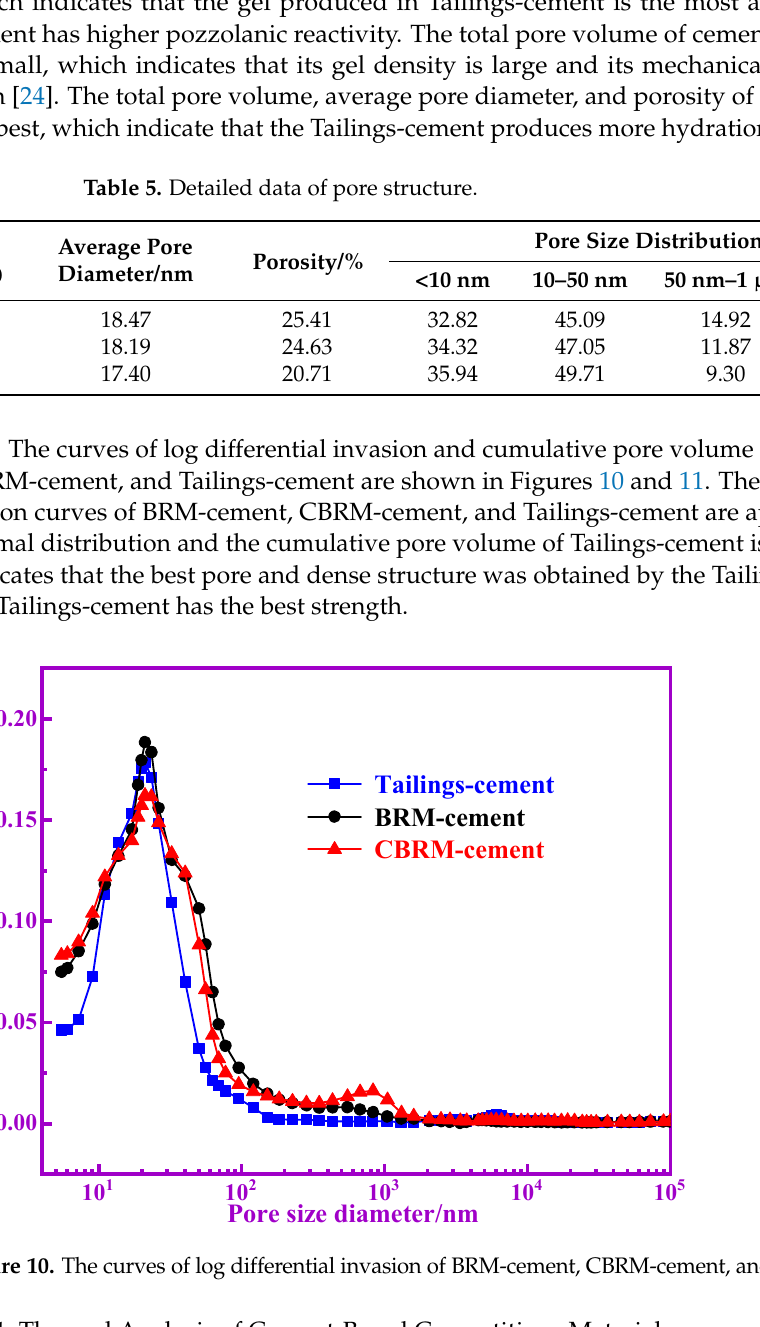
Figure 11. The curves of cumulative pore volume of BRM-cement, CBRM-cement, and Tailings-ce- ment. 3.3.4. Thermal Analysis of Cement-Based Cementitious Materials The TG-DTG curves of the hardened paste of BRM-cement, CBRM-cement, and Tail- ings-cement at 28 d are shown in Figure 12. The mass loss of BRM-cement, CBRM-cement, and Tailings-cement is continuous with the increase of temperature, and their total mass loss is 20.86%, 23.02%, and 22.40%, respectively. The mass loss of BRM-cement, CBRM- cement, and Tailings-cement can be divided into four main ranges: The first range is 30– 100 °C, which represents the mass loss of free water in hardened paste. The second range is 100–300 °C, which represents the mass loss of bound water of C-S-H gel, C(N)-A-S-H gel, and ettringite in BRM-cement, CBRM-cement, and Tailings-cement [25]. The third temperature range is about 300–750 °C, which represents the decomposition of Si(Al)-OH structure and Ca(OH) 2 in BRM-cement, CBRM-cement, and Tailings-cement [26]. The fourth temperature range is about 750–1000 °C, which corresponds to the decomposition of calcium carbonate in BRM-cement, CBRM-cement, and Tailings-cement. The mass loss parameters of BRM-cement, CBRM-cement, and Tailings-cement in different ranges are shown in Table 6. The mass loss of BRM-cement, CBRM-cement, and